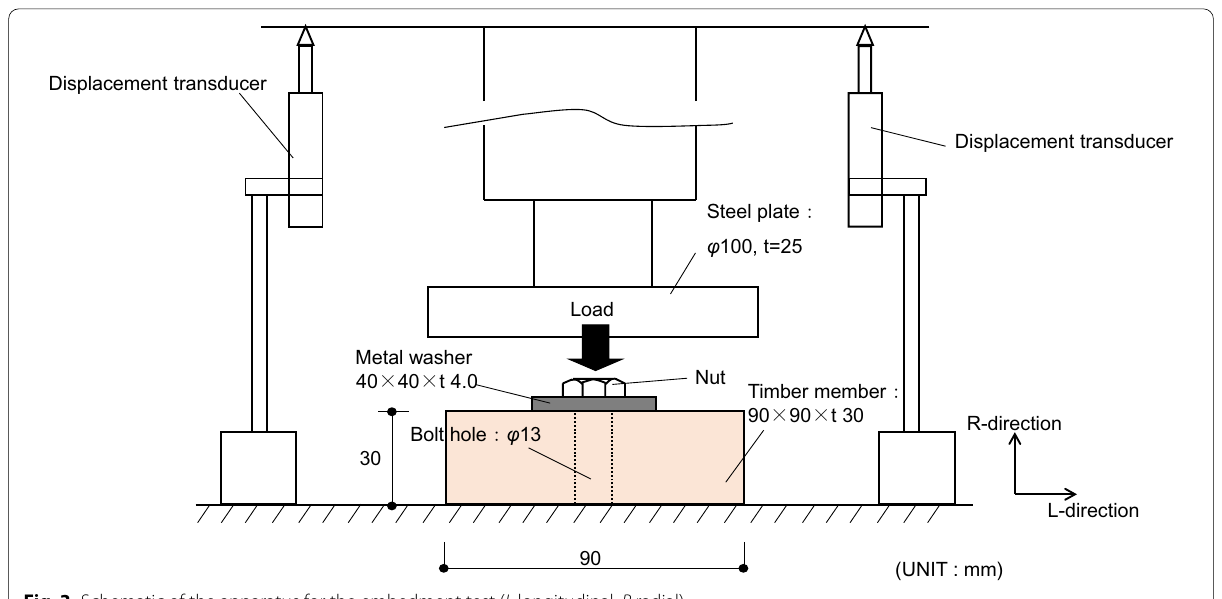
Fig. 3 Schematic of the apparatus for the embedment test ( L longitudinal, R radial)